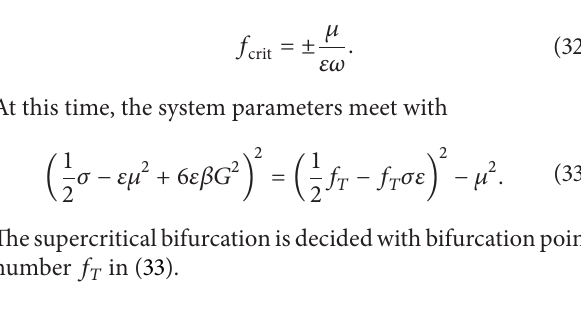
Figure 3: Amplitude-inclination angle curves with various deck vibration frequencies. Table 1: The essential parameters of the